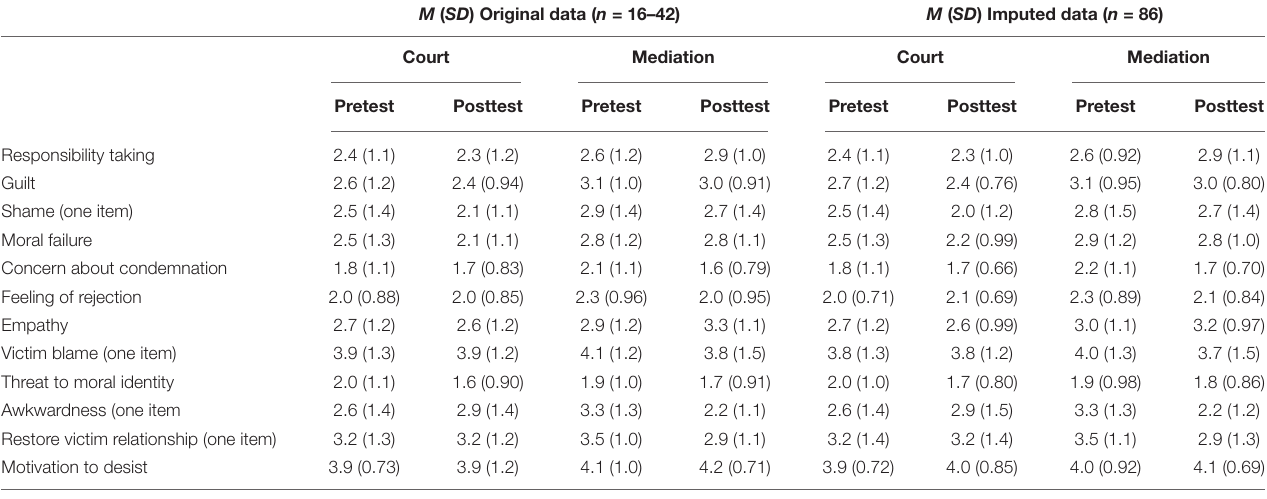
TABLE 3 | Means, standard deviations, and number of participants per variable per group.